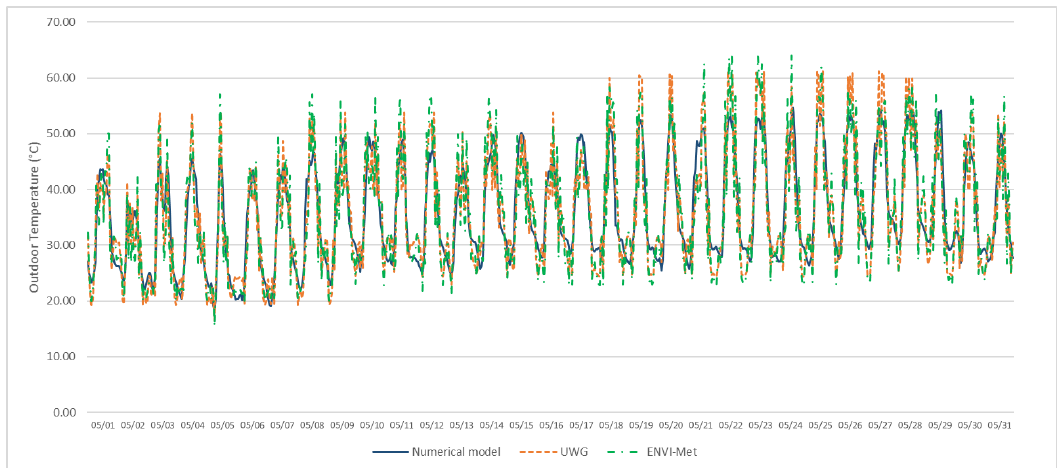
Figure 10. Hourly outdoor temperatures for May on Barcelona comparing the numerical model developed here, UWG, and ENVI-Met.